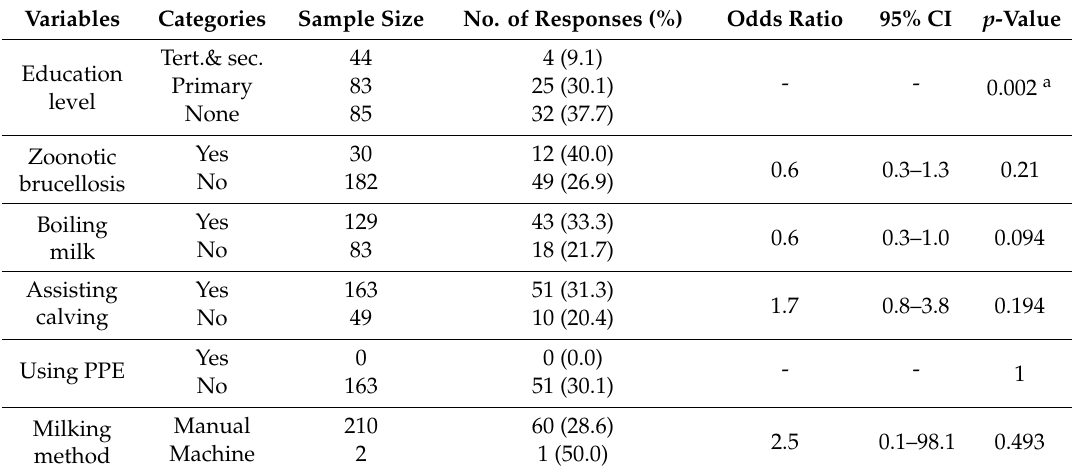
Table 4. Univariate associations between public health risk factors and herd brucellosis seropositivity among cattle keepers residing at the wildlife-livestock-human interface in